Question: Reading the figure, is the described quantity rising or falling?
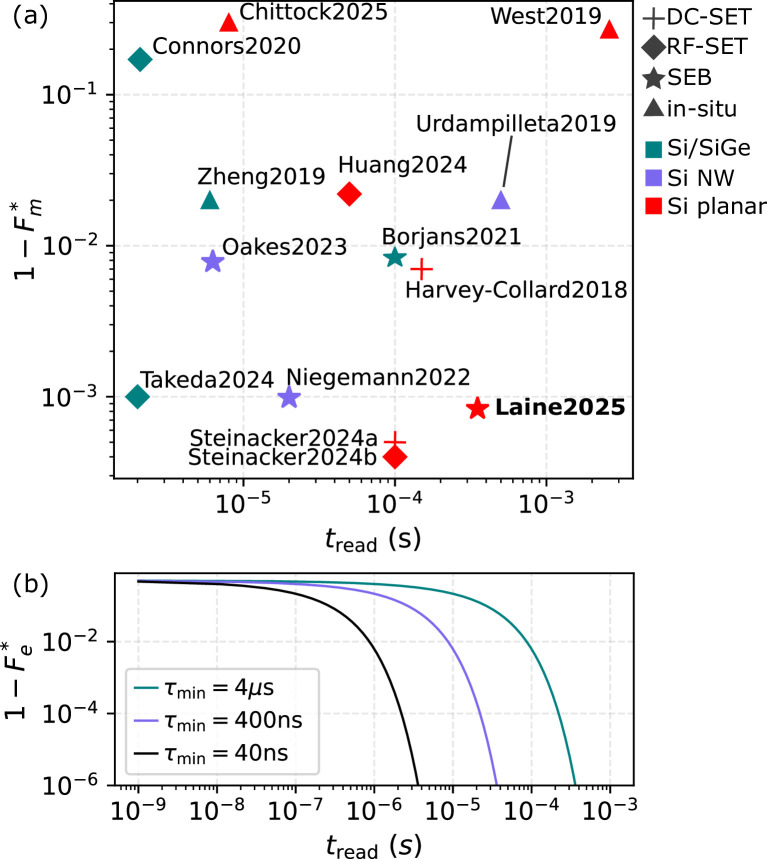
Answer: increasing